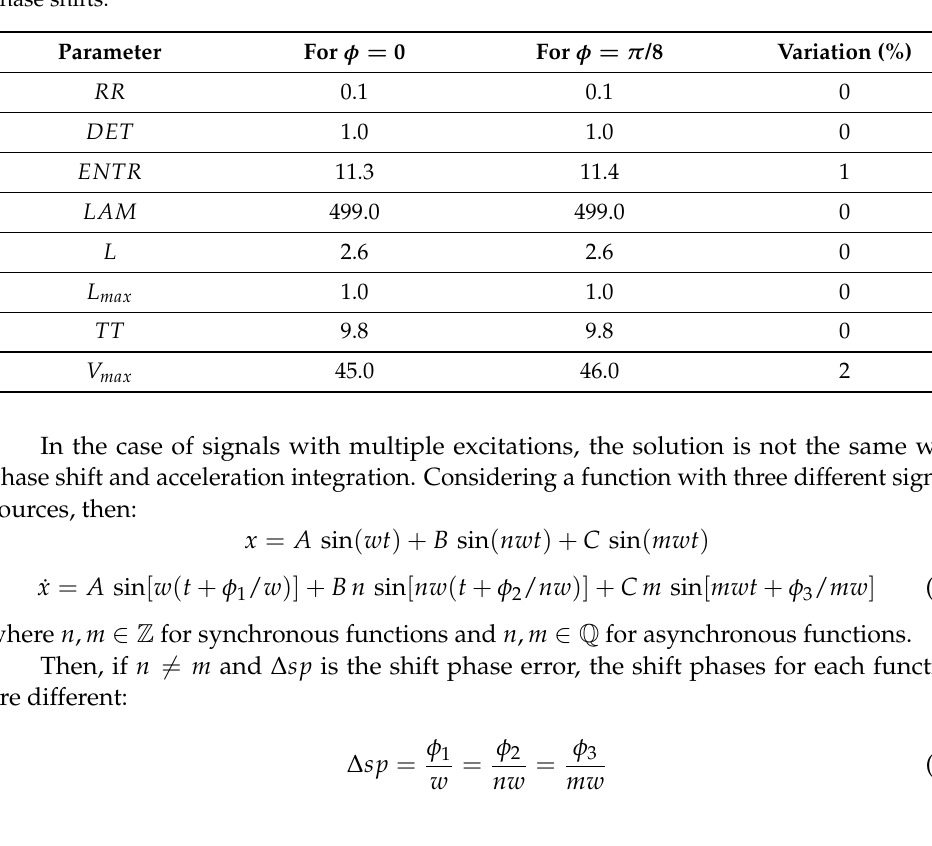
Table 1. Recurrence quantification analysis (RQA) quantification of the single function with different phase